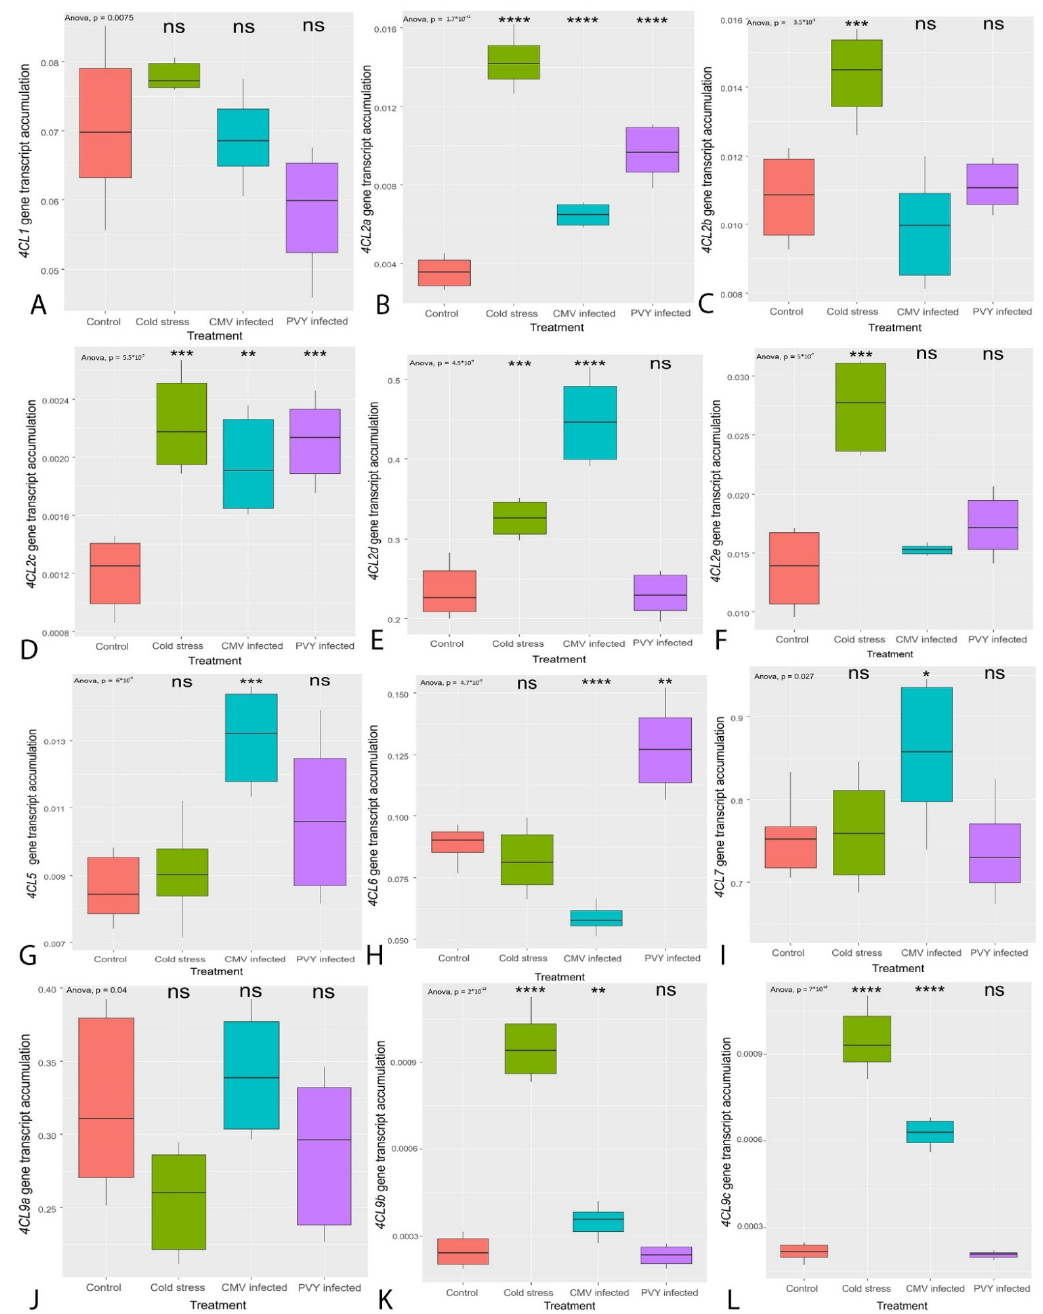
Figure 4. Transcription of the genes encoding for 4-coumarate-CoA ligase (4CL) isoenzymes (( A ): 4CL1, ( B ): 4CL2a, ( C ): 4CL2b, ( D ): 4CL2c, ( E ): 4CL2d, ( F ): 4CL2e, ( G ): 4CL5, ( H ): 4CL6, ( I ): 4CL7, ( J ): 4CL9a, ( K ): 4CL9b, ( L ): 4CL9c) of tomato leaves (cv. Elpida) following plant exposure to cold stress (5 ◦ C for 16 h) or inoculation (20 d) with either cucumber mosaic virus (CMV) or potato virus Y (PVY). Significant differences were determined by one-way ANOVA comparisons ( p ≤ 5%). Signif. codes: ns: non-significant; 0.05: *; 0.01: **; 0.001: ***; 0: